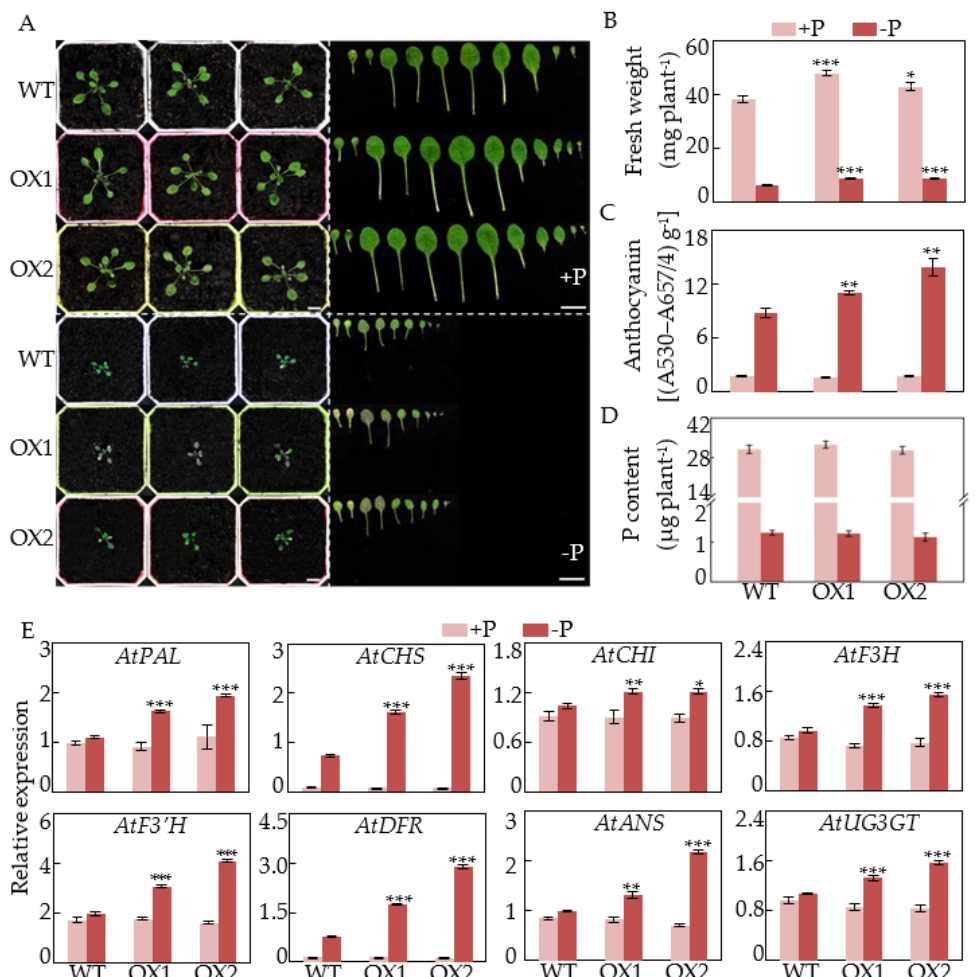
Figure 5. Effects of GmCSN5A overexpression on anthocyanin accumulation in Arabidopsis. ( A ) The phenotypes. Bars = 1 cm. ( B ) Fresh weight. ( C ) Anthocyanin content. ( D ) P content. ( E ) Relative expression of eight genes in anthocyanin biosynthetic pathway. Seedlings were grown in peat soils for 8 d. Data are means of four independent replicates ± SE. Asterisks indicate significant difference between GmCSN5A overexpressing Arabidopsis and WT in the Student’s t -test (* p < 0.05; ** p < 0.01; *** p < 0.001).